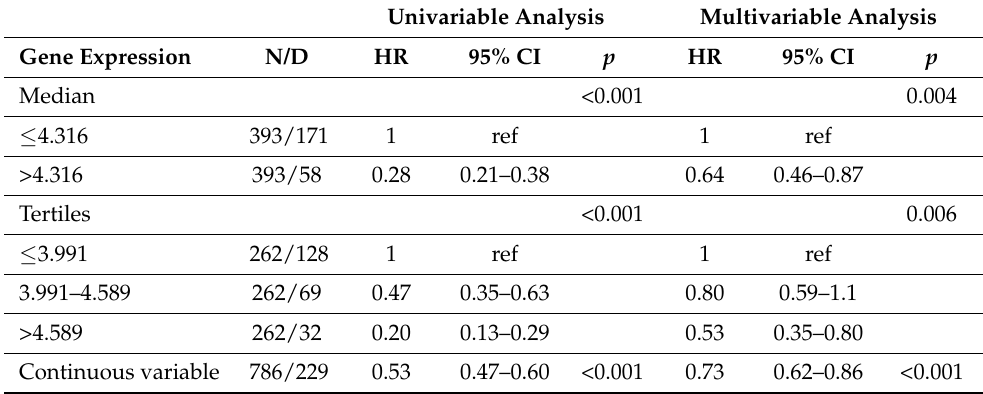
Table 4. Overall Survival of 786 NB patients in relation to MYT1L expression levels evaluated by the Cox